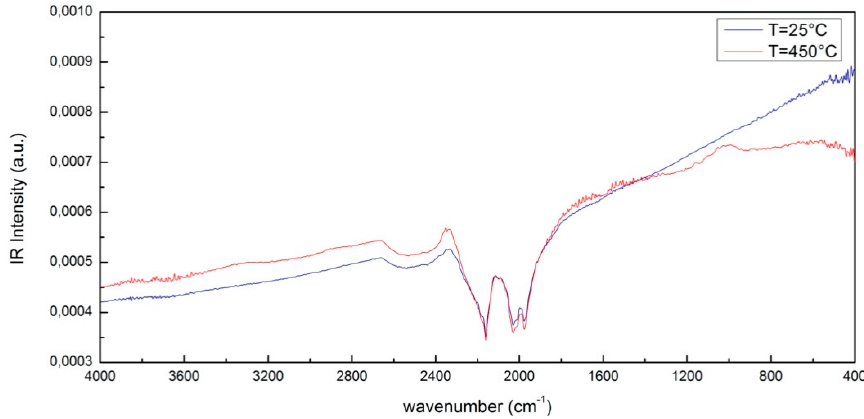
Figure 1. A comparison between the IR spectrum of CNTs at T = 25 °C and at T = 450 °C.